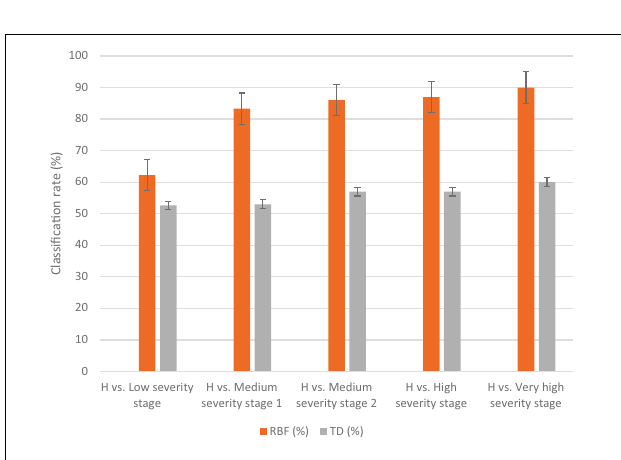
H vs. Medium severity stage 2